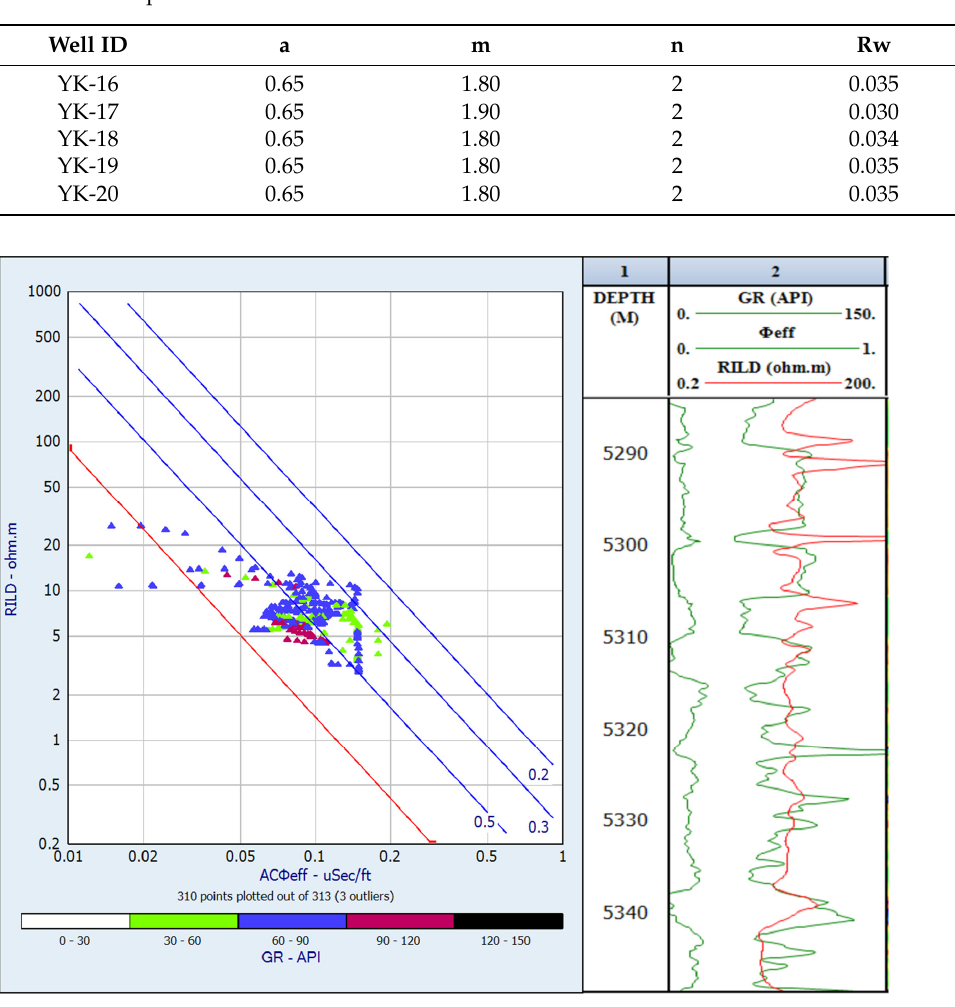
Figure 18. Picket plots (RILD/Ac_Φeff cross plot) for YK-16 with discriminator gamma ray